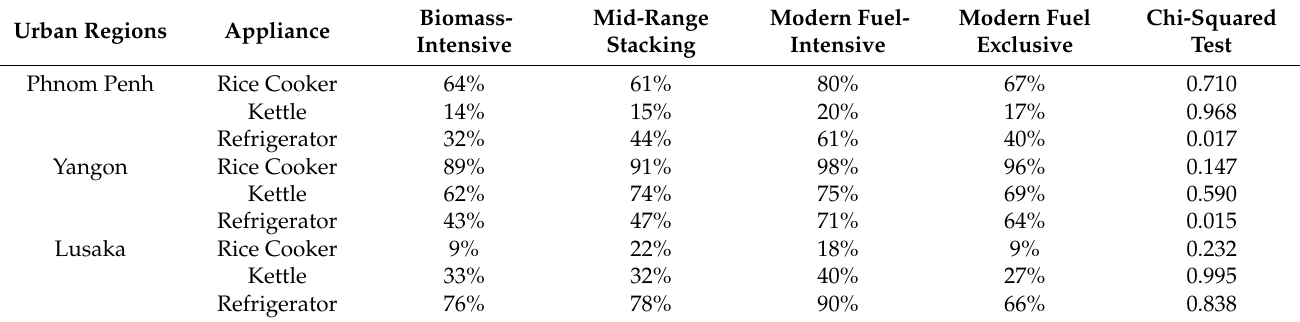
Table 11. Appliance ownership rate (households that did not complete this section of the survey are omitted). Urban